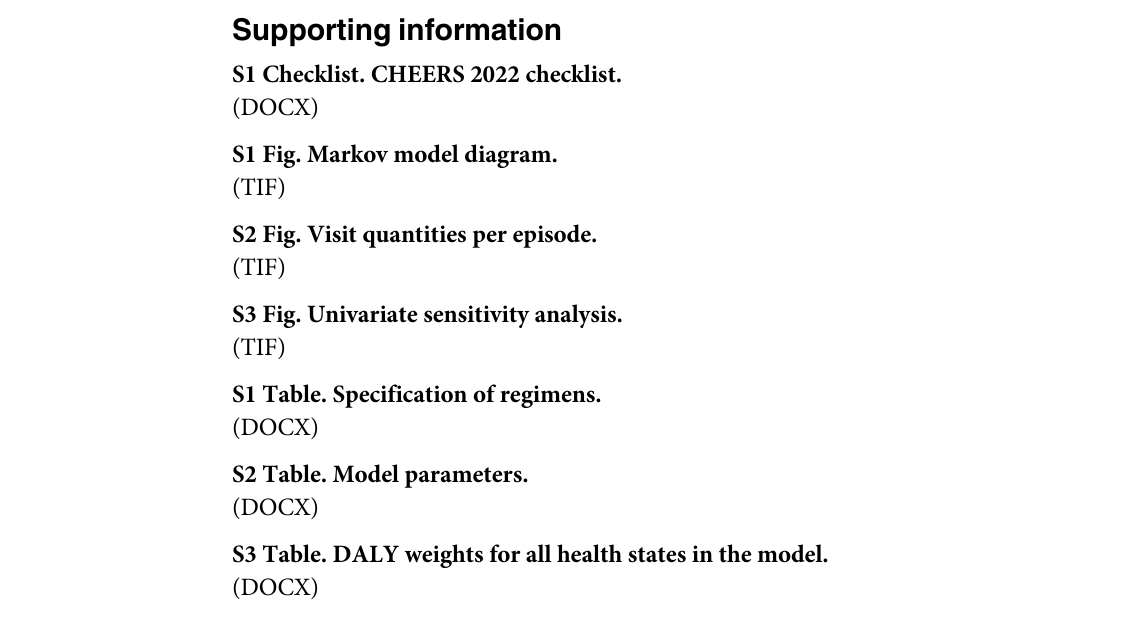
S3 Table. DALY weights for all health states in the model.